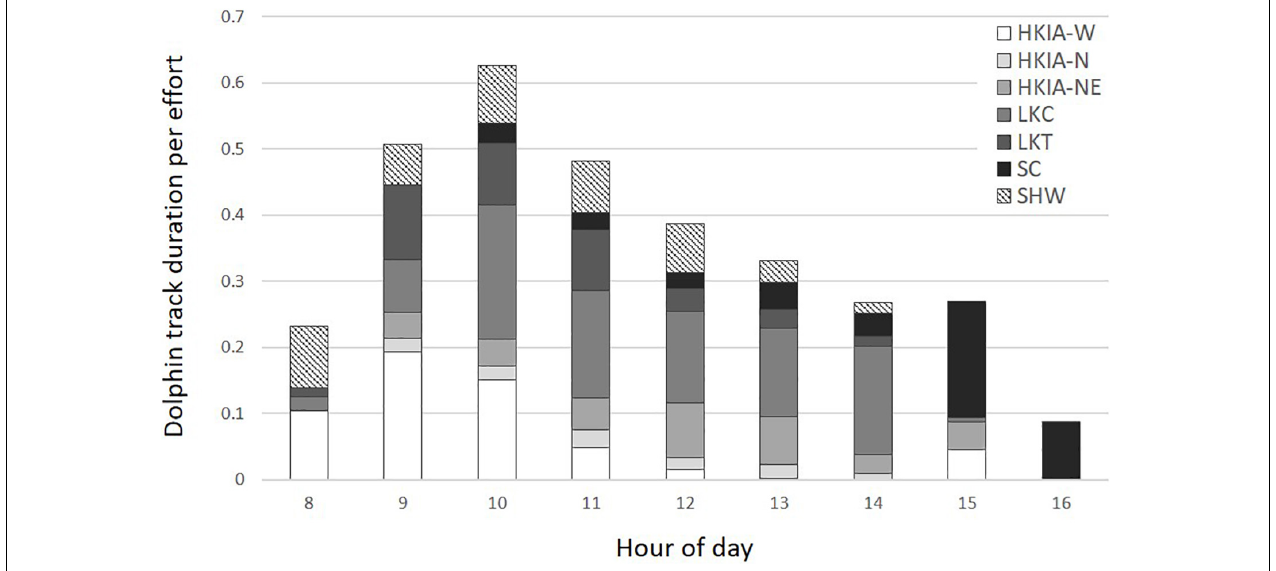
FIGURE 3 | Indo-Pacific humpback dolphin track duration per effort based on hour of day.